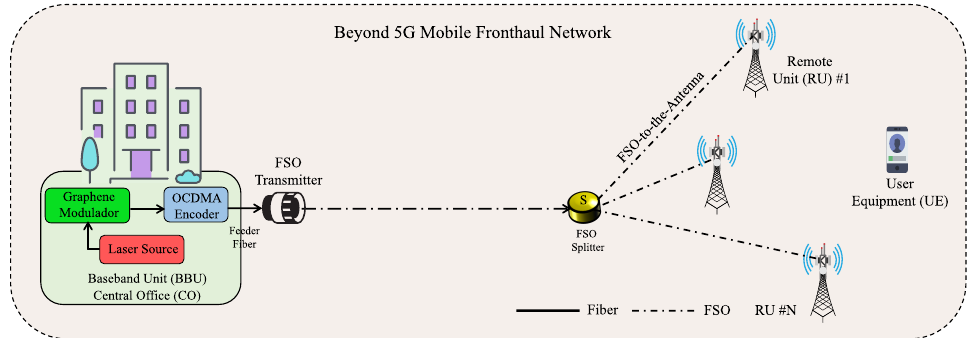
Figure 1. Architecture of the mobile fronthaul network based on FSO, graphene modulator, and spread spectrum codes. FSO: free-space optics. OCDMA: optical code-division